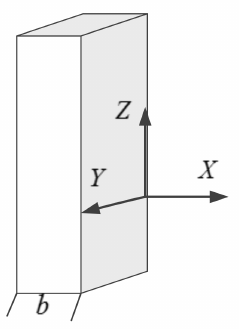
Figure 3. Schematic view of a single